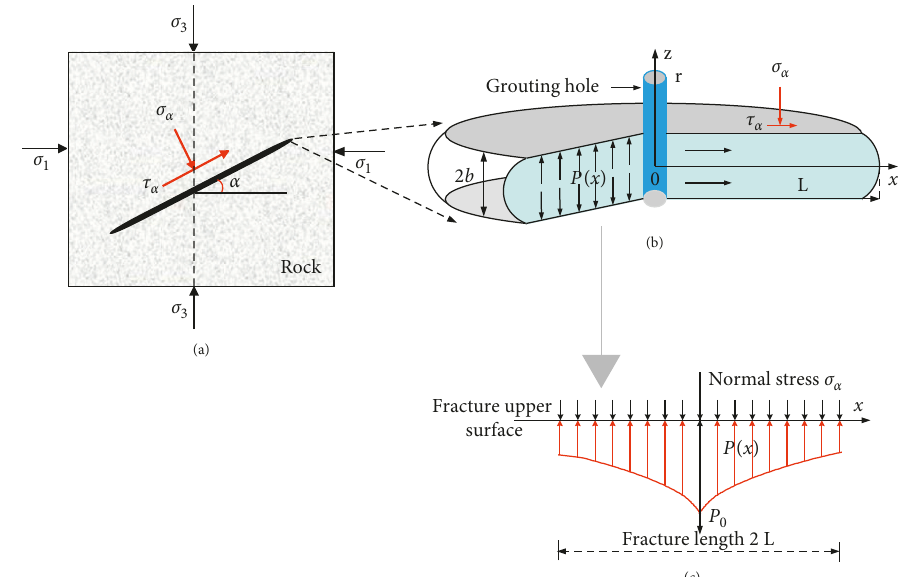
Figure 1: Force diagram of a fracture. (a) Single-fracture stress. (b) Fracturing diffusion model of single fracture. (c) Pressure distribution in fracture. σ is the normal stress on the fracture’s surface; τ is the shear stress on the fracture’s surface; r is the radius of the grouting hole; 2 b α α is the height of the fracture channel; L is the fracture length; and w ( x ) corresponds to the fracture width at different values of x .